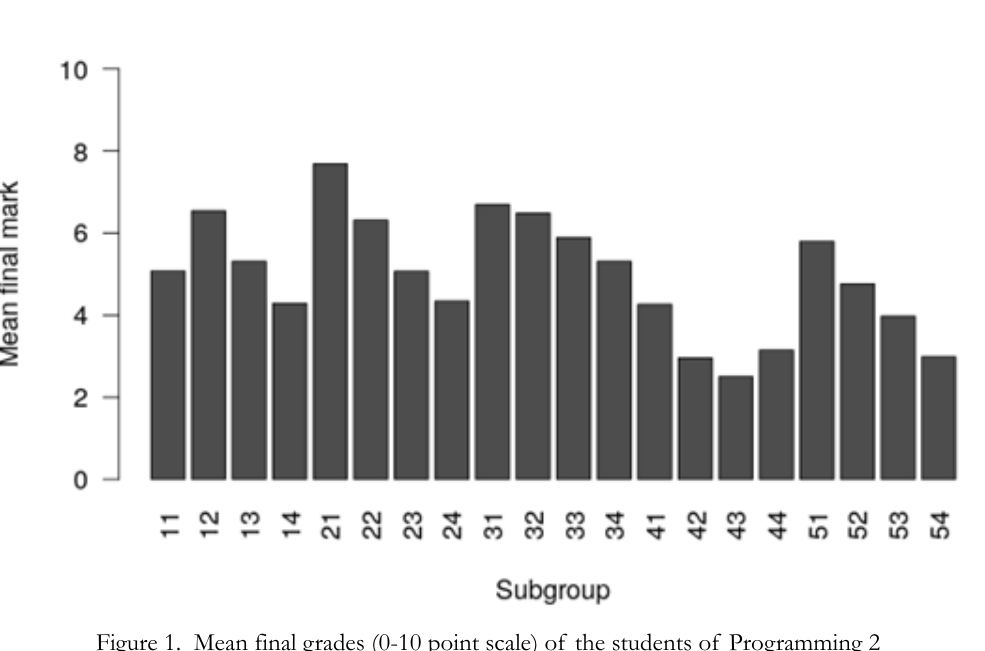
Figure 1. Mean final grades (0-10 point scale) of the students of Programming 2 (PRO2) in the spring semester (2015) classified by the laboratory of computer science subgroup. Laboratory subgroups are codified with two digits, xy, where x is the (theory) group number and y the (lab) subgroup number (thus subgroup 24 means that the students belongs to the theory group number 2 and to the 4th lab